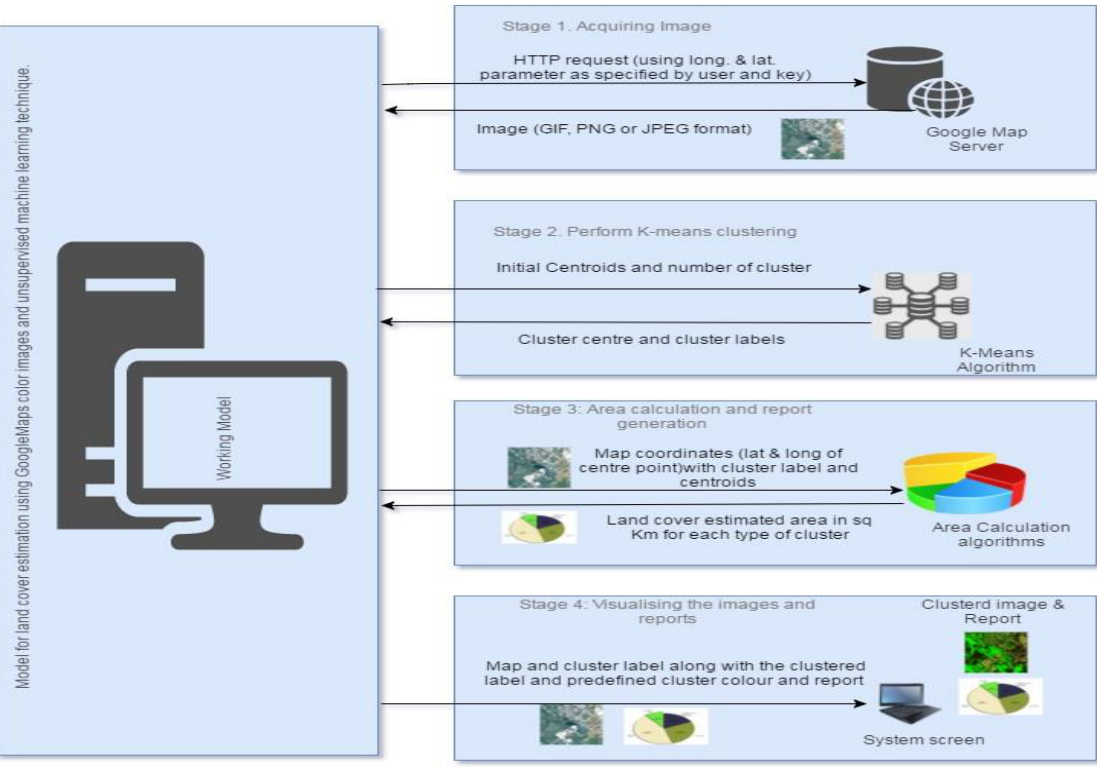
Figure. 2 Depicting the stages in the